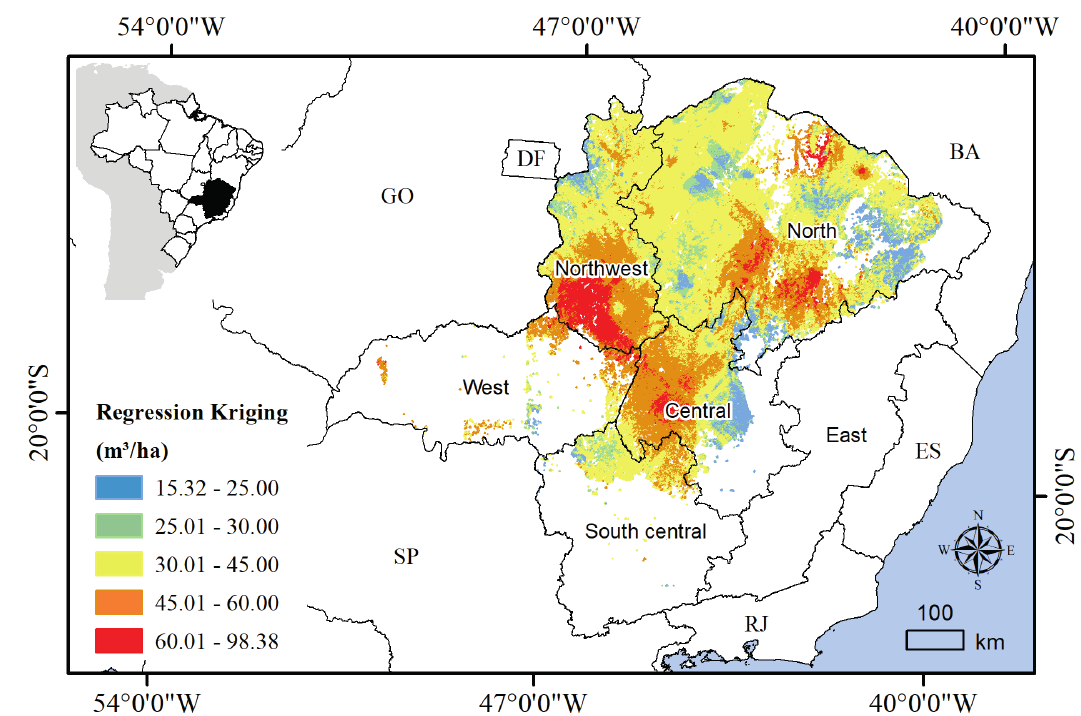
Figure 7 - Map of wood volume (m 3 /ha) obtained by regression kriging for the Cerrado Sensu Stricto in the state of Minas